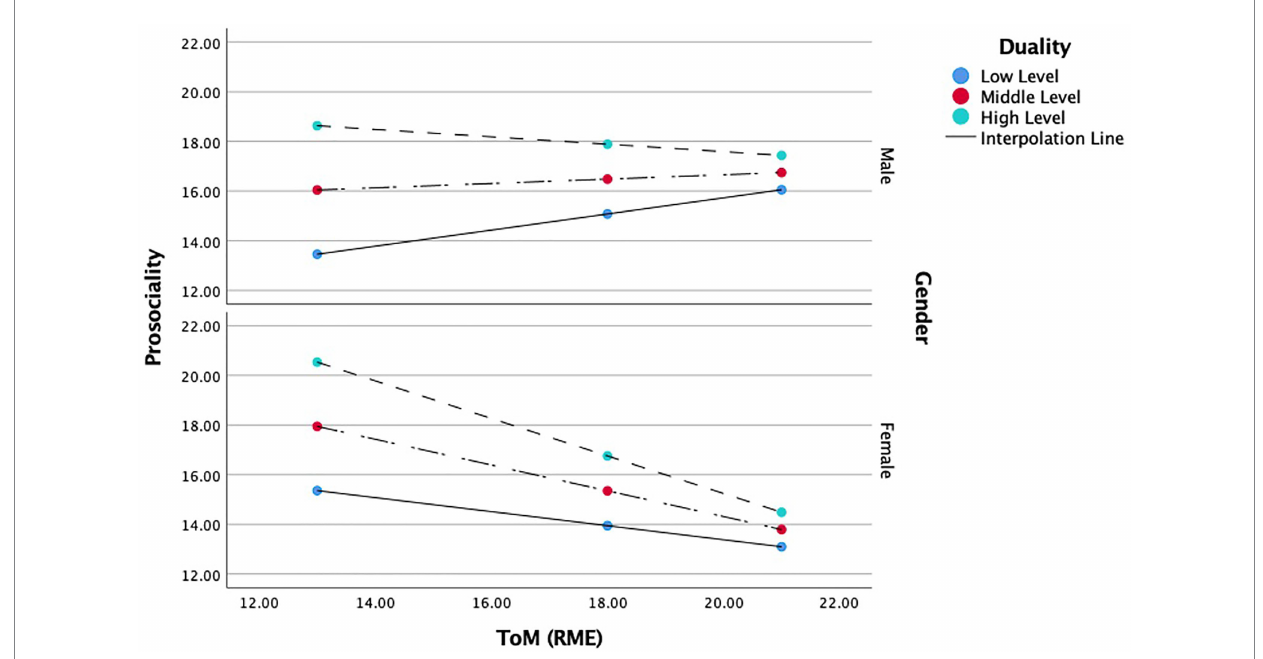
FIGURE 2 Moderating role of duality and gender in the relationship between ToM and